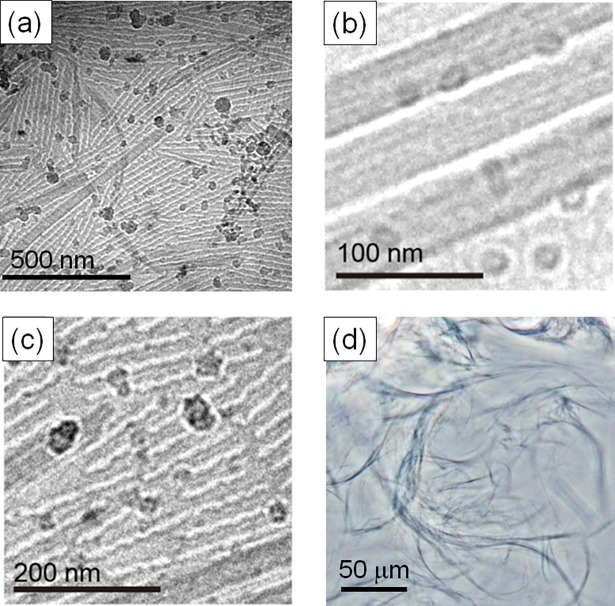
(a–c) Cryo-TEM images and (d) optical microscope image of ATBAG.